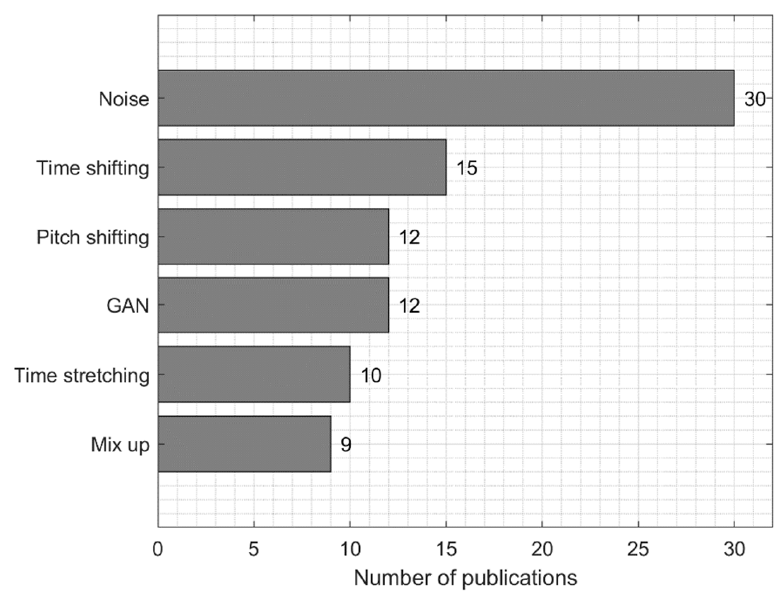
Figure 6. Data augmentation approaches from analyzed articles.